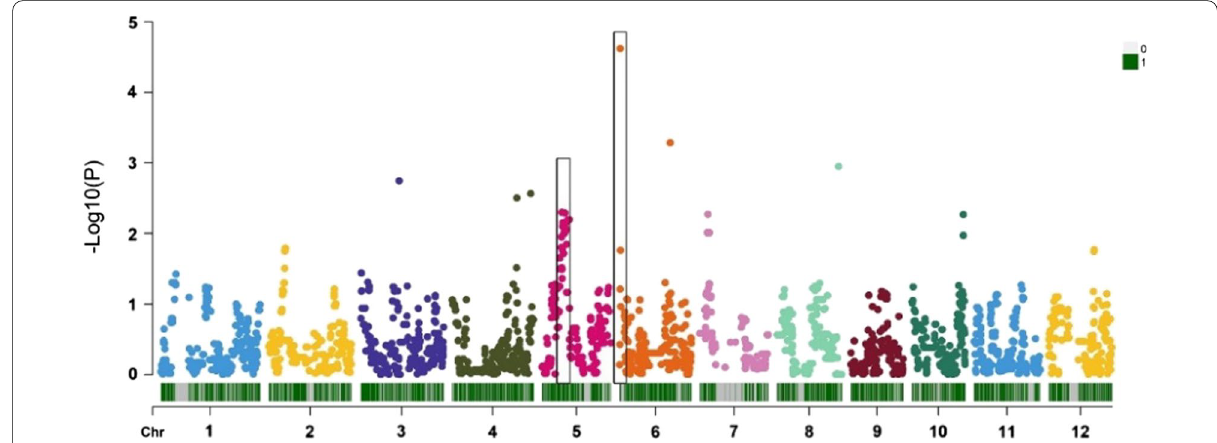
Fig. 2 QTL mapping result of survival rate from RTM-GWAS. The black box represents the QTL repeatedly detected by R/qtl and